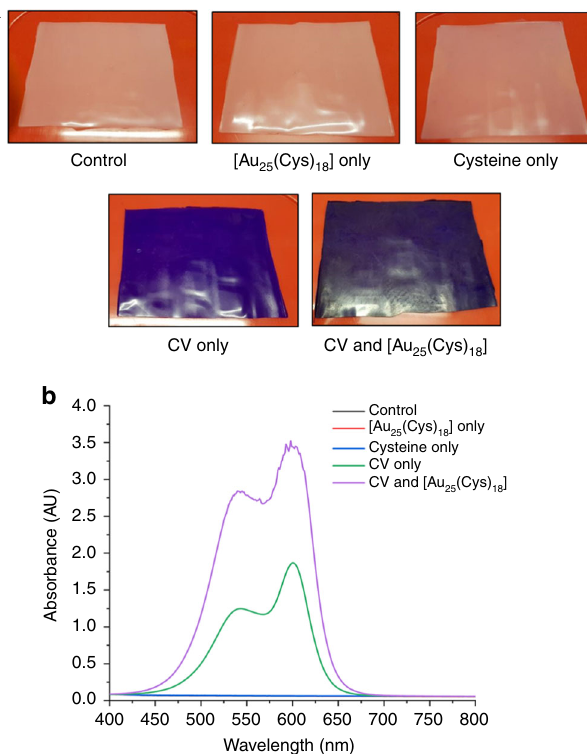
Fig. 2 Images and UV – Vis measurement of 24 h treated silicones. a Images of control, CV only, [Au 25 (Cys) 18 ] only, cysteine only and CV& [Au 25 (Cys) 18 ]. CV indicates crystal violet. b UV – Vis absorbance spectra of control, CV only, [Au 25 (Cys) 18 ] only, cysteine only and CV&[Au 25 (Cys) 18 ].